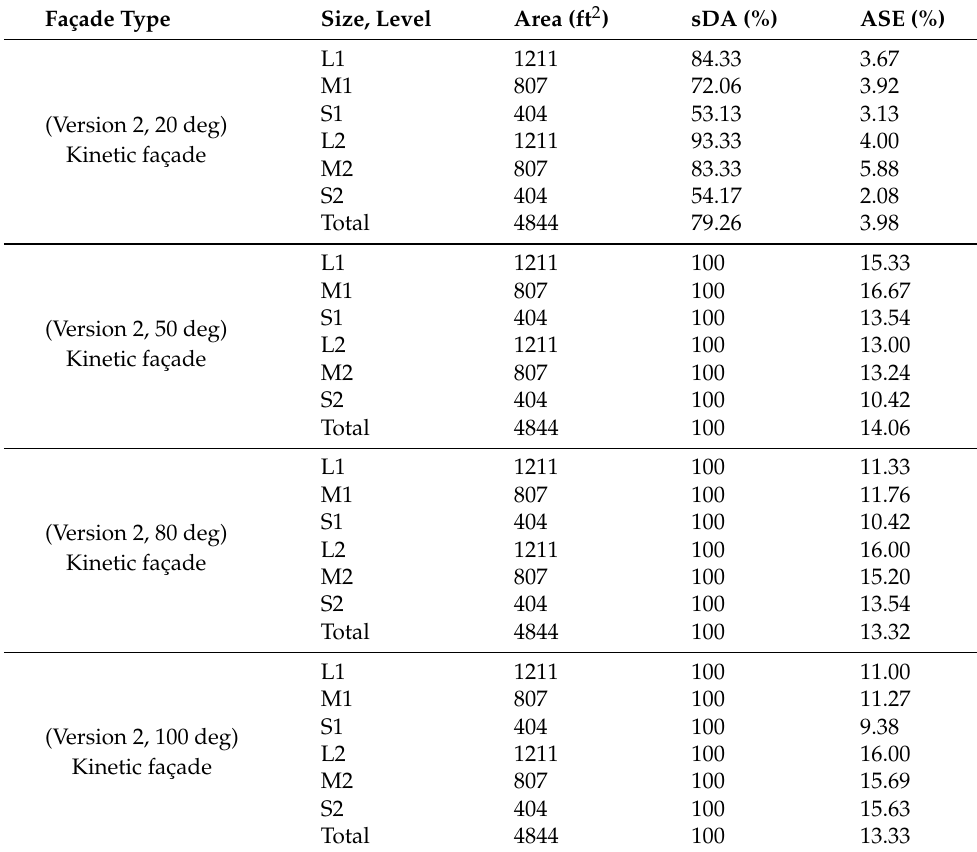
Table 3. The results after the simulation of the kinetic façade (version 2: twisting movement) in terms of LEED version 4.1